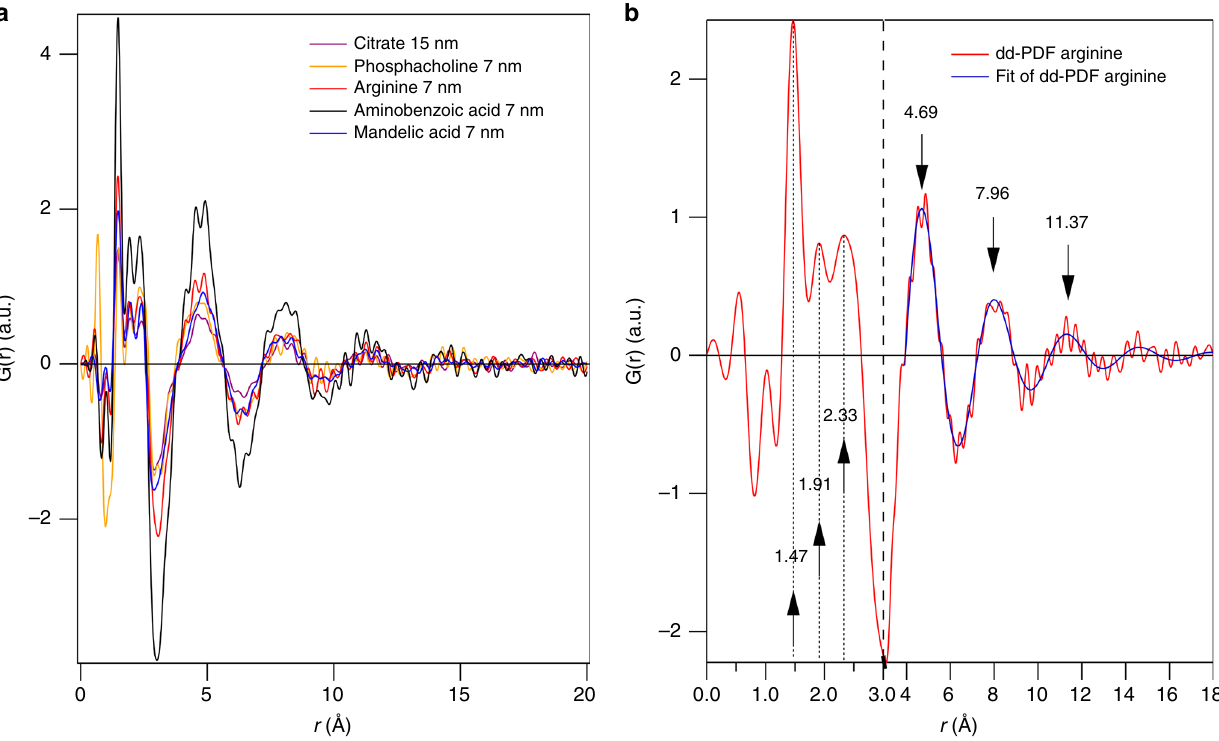
Fig. 2 Adsorbed water and hydration layers for various ligands. a Scaled hydration shells (double difference PDFs (dd-PDF)) of differently sized and functionalized iron oxide nanoparticles (IONPs) of selected samples (one capping agent of each group of Supplementary Figure 2; data of remaining sample shown in Supplementary Figure 11). b Scaled hydration shell of L -arginine-capped IONPs with its fi t of a sinusoidal oscillation to weaker bound hydration shells at 4.69, 7.96 and 11.37 Å. The x -axis is split at 3 Å and expanded for lower distances, in order two better show the three sharp peaks due to absorbed water at 1.47, 1.91 and 2.33 Å